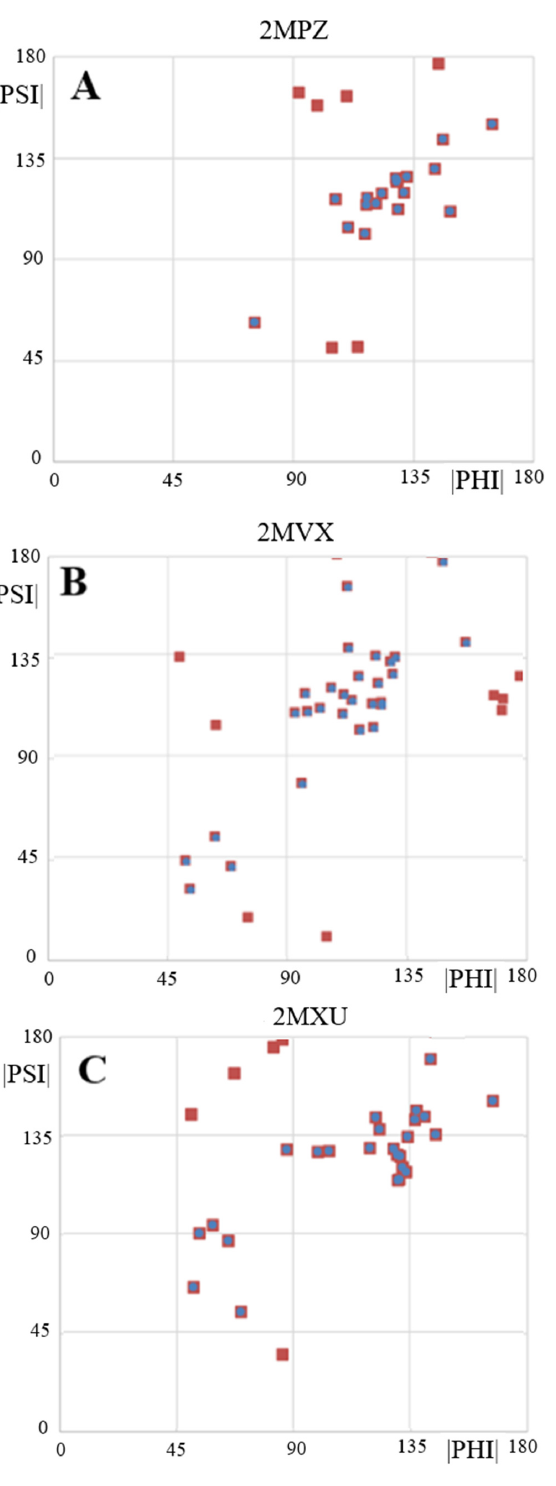
Figure 5. List of point distributions representing Phi and Psi angles following transformation |Psi| and |Phi|, in the case of: ( A )—2MPZ—Amino acids were highlighted in the 3D presentation as in point B; ( B )—2MVX—in a 3D presentation ice blue—items eliminated as outstanding; red—amino acids with L α conformation; cyan—amino acids with R α conformation; ( C )—2MXU—Amino acids were highlighted in the 3D presentation as in point B. Red points on the maps represent all con- formations present in the polypeptide, blue points—points remaining after outstanding points are eliminated. 3D presentations—yellow residues—N-terminal of amino acids for easy